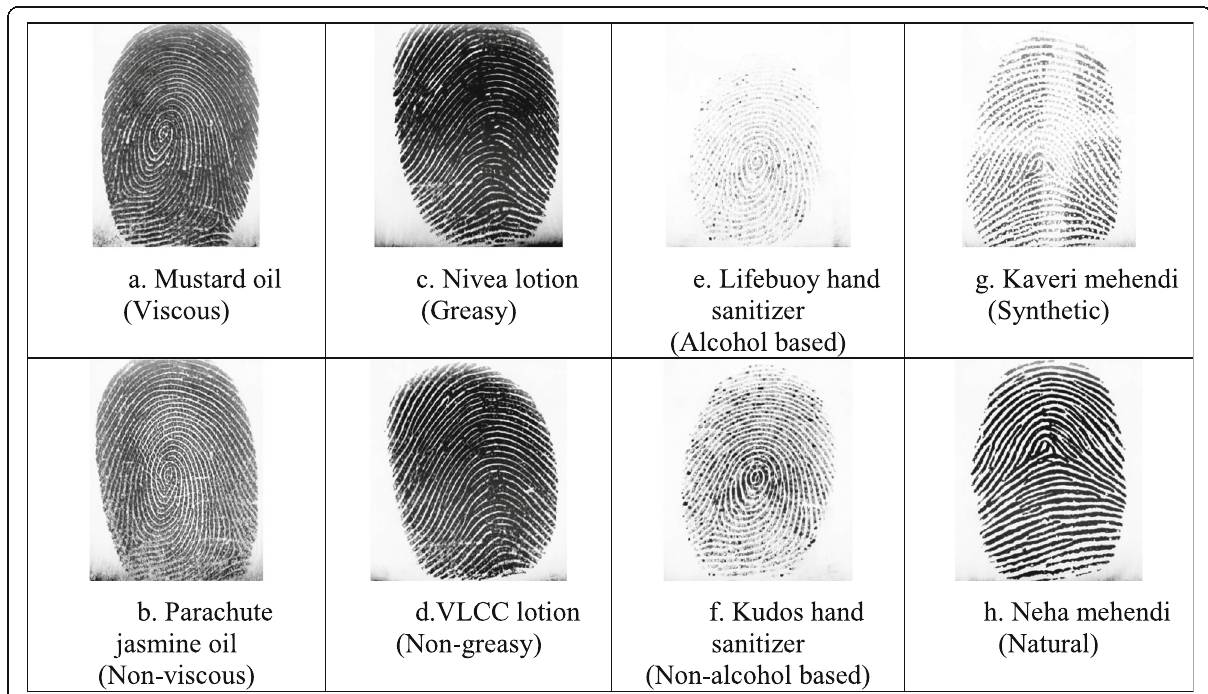
Fig. 3 Fingerprint images recorded after application of cosmetic and daily use products. a Mustard oil (viscous). b Parachute jasmine oil (non- viscous). c Nivea lotion (greasy). d VLCC lotion (non-greasy). e Lifebuoy hand sanitizer (alcohol-based). f Kudos hand sanitizer (non-alcohol-based). g Kaveri mehendi (synthetic). h Neha mehendi